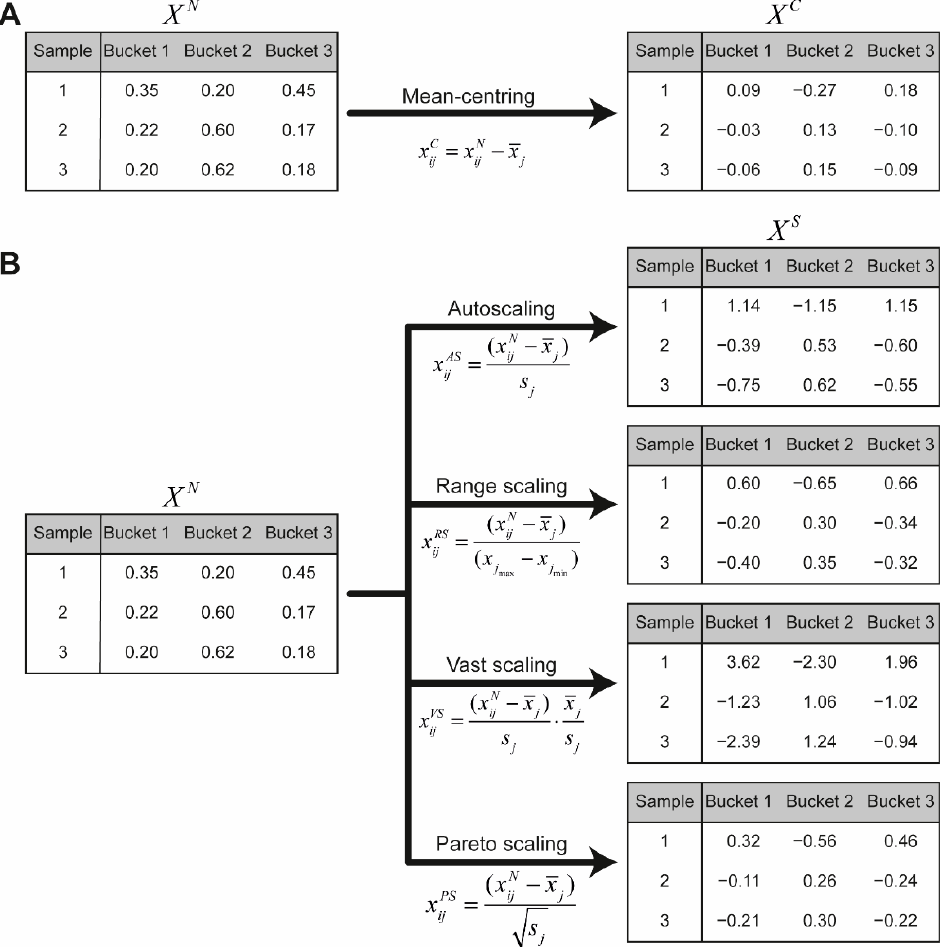
Figure 6. ( a ) Every column of the normalised data matrix X N is mean centred to obtain the data matrix X C . ( b ) Every column in the normalised data matrix X N is scaled using the different methods. The obtained data matrix X S is used for multivariate analysis. x j and s j are, respectively, the mean and standard deviation of the values of the j th column.